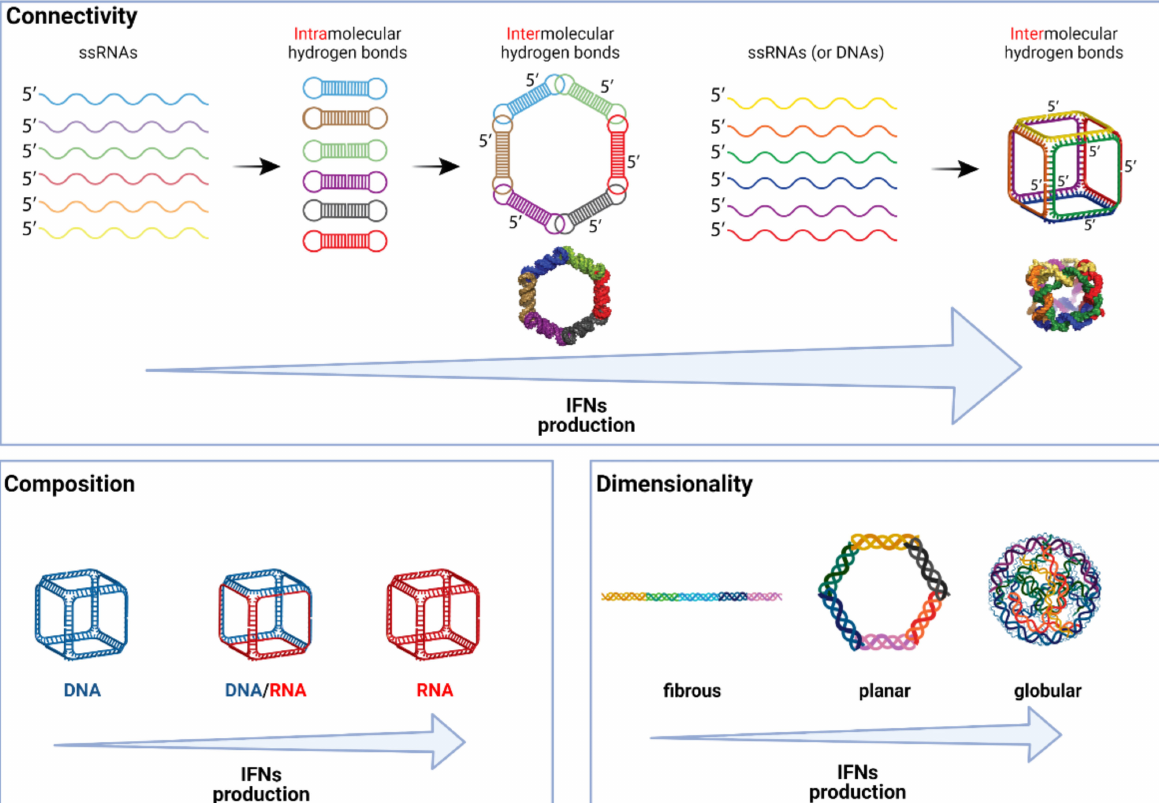
Figure 2. Influence of physicochemical properties on immune stimulation. The main characteristics of NANPs that affect their immunostimulation are connectivity (how individual NANP strands are assembled), composition (number of RNA strands vs. DNA), and dimensionality (3D